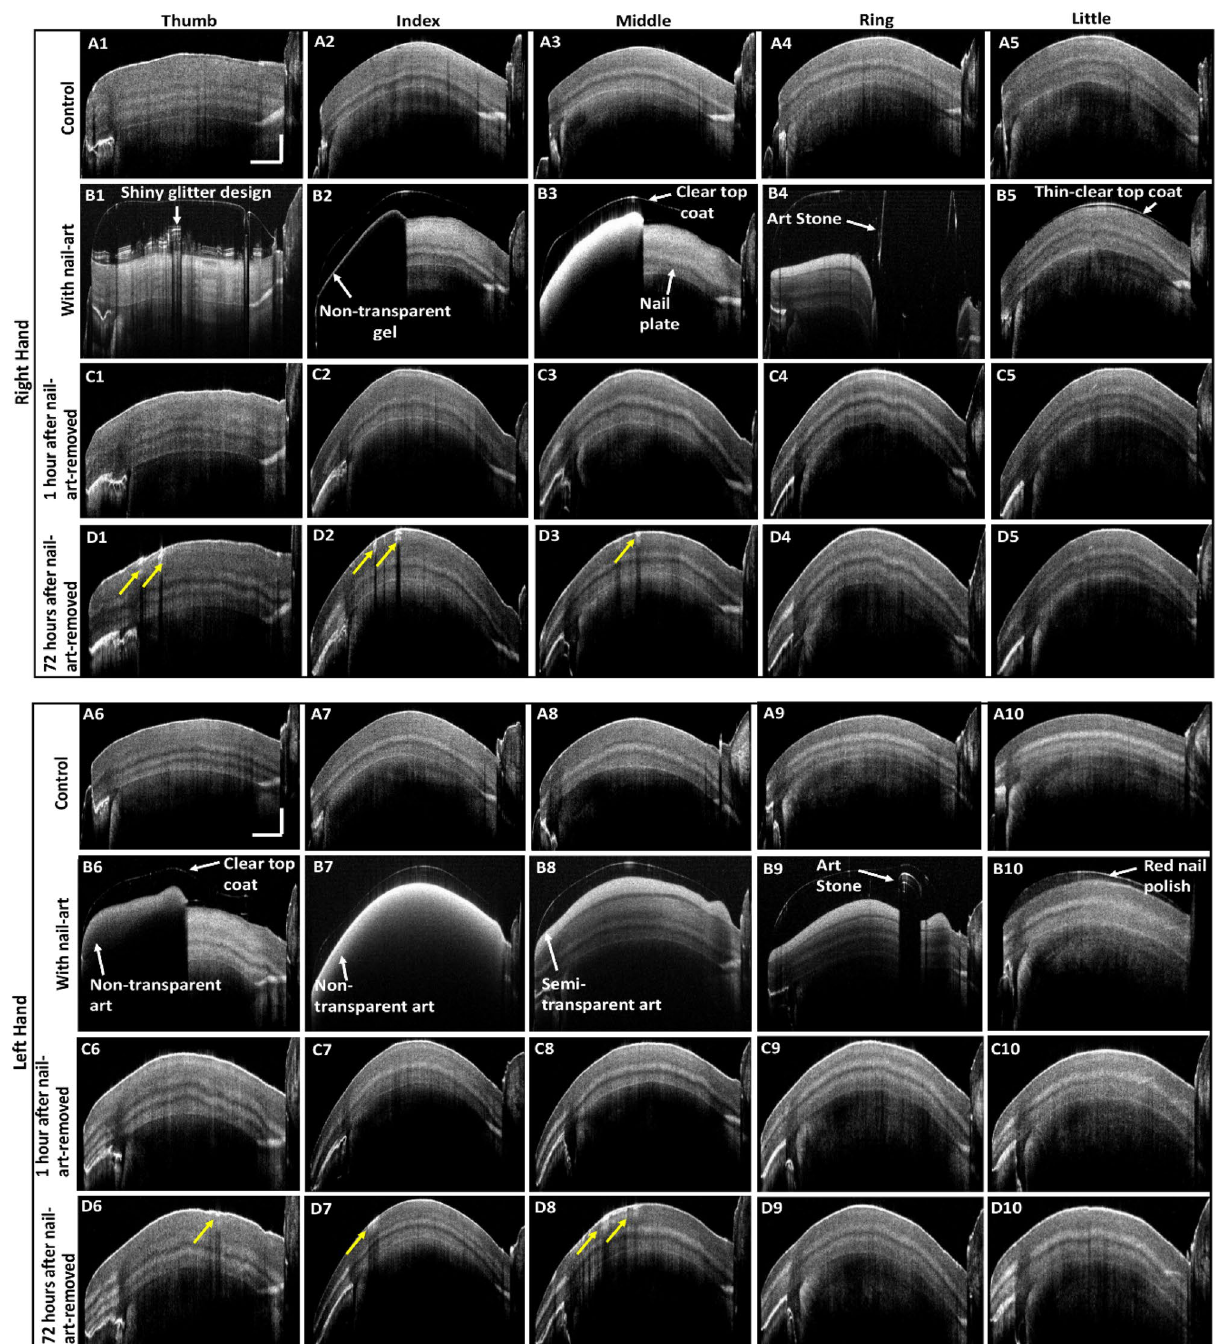
Figure 5. 2D OCT images of control, with nail-art, and art-removed nails. Images ( A1 – A10 ) 2D-OCT images of control fingernails of right and left hands. Images ( B1 – B10 ) 2D-OCT images of right and left hands fingernails with nail-art. Images ( C1 – C10 ) 2D-OCT images of right and left hands fingernails after 1 h of nail- art removal. Images ( D1 – D10 ) 2D-OCT images of right and left hands fingernails after 72 h of nail-art removal. The values of horizontal and vertical scale bars are 2 mm and 0.5 mm, created a total reflection of scanning laser light during imaging and underneath the nail cracks light could not pass in the depth direction of the nail plate and created the black spots in enface images. In control enface images of both right and left hands, no black spots can be detected, because there was no total reflection of scanning laser light from the crack-free nail plates of control nails. Backscattered intensity difference of control and art‑removed nails. An intensity difference can be detected between control and art-removed nails. 2D images of control and art-removed nails were further